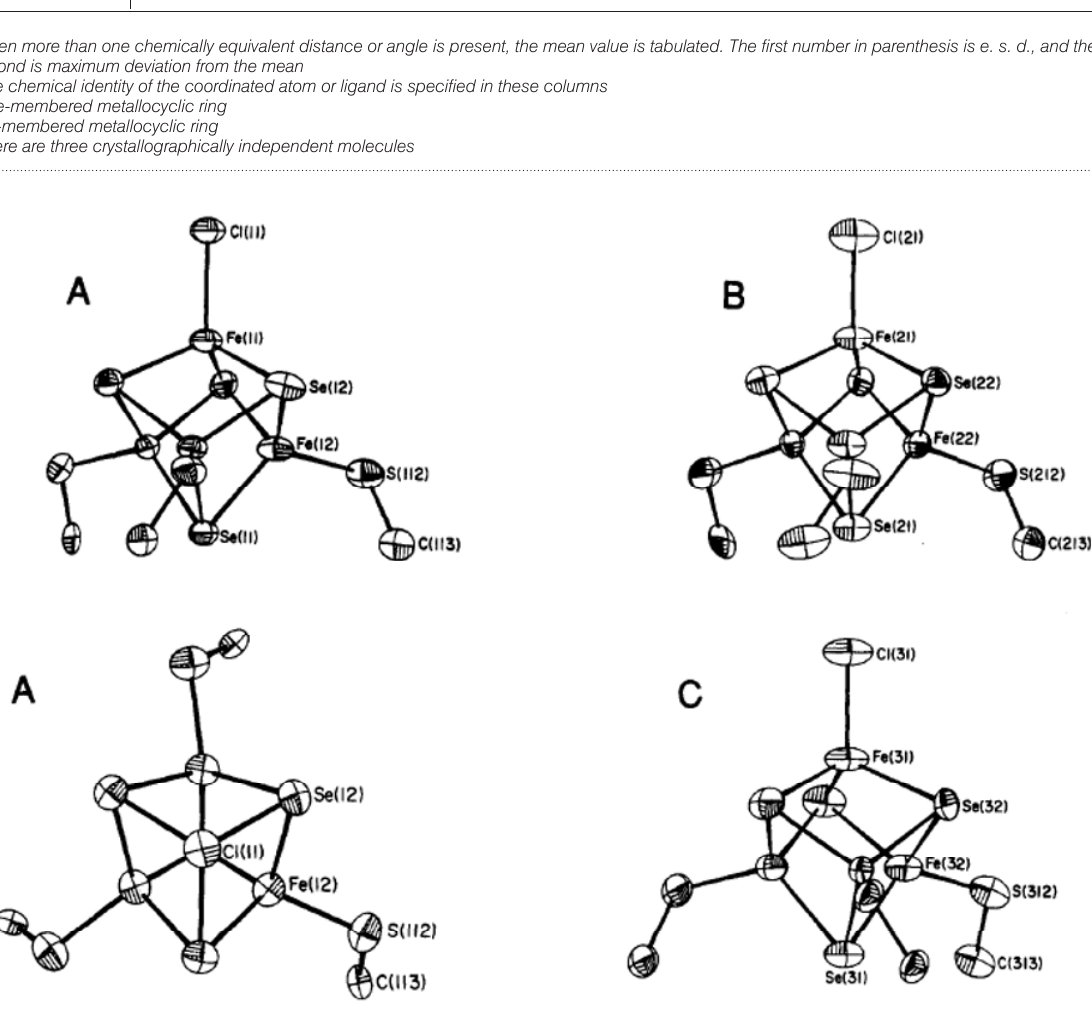
-Se) ( η 3 -dmtb)Cl] 2- 3 4